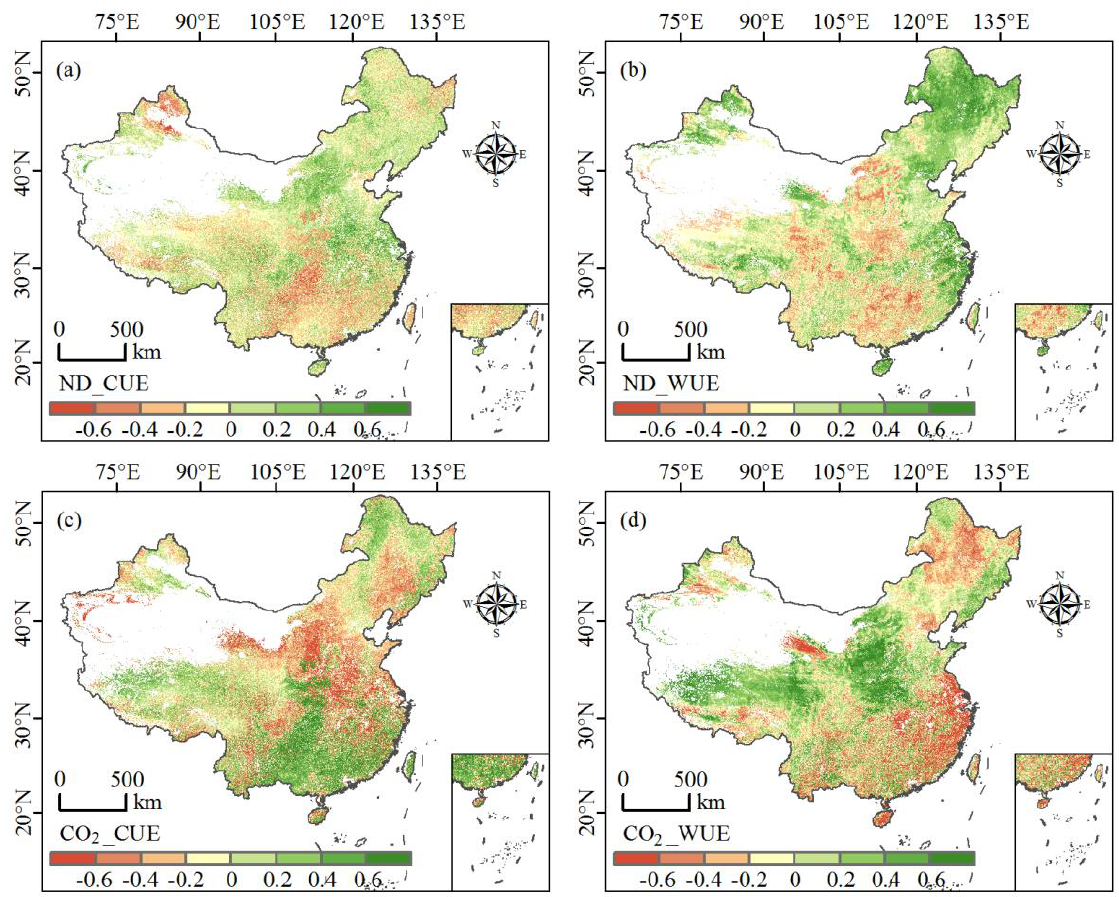
Figure 4. Effects of ND and CO 2 on CUE and WUE. ( a , b ) The effects of ND on CUE and WUE, and ( c , d ) the effects of CO 2 on CUE and WUE.